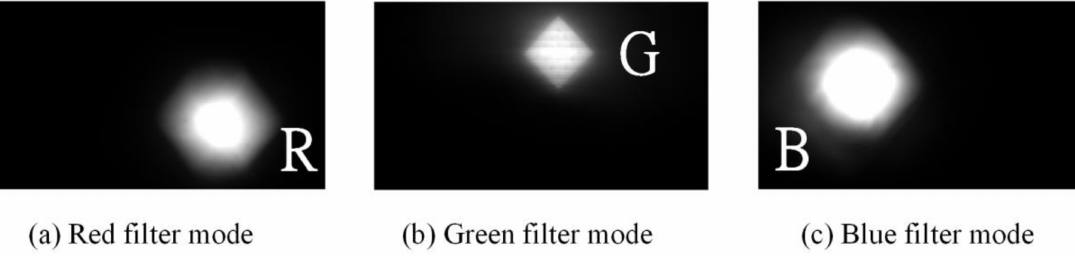
Figure 6. Received lights at OT_Rx with the aid of physical bandpass optical